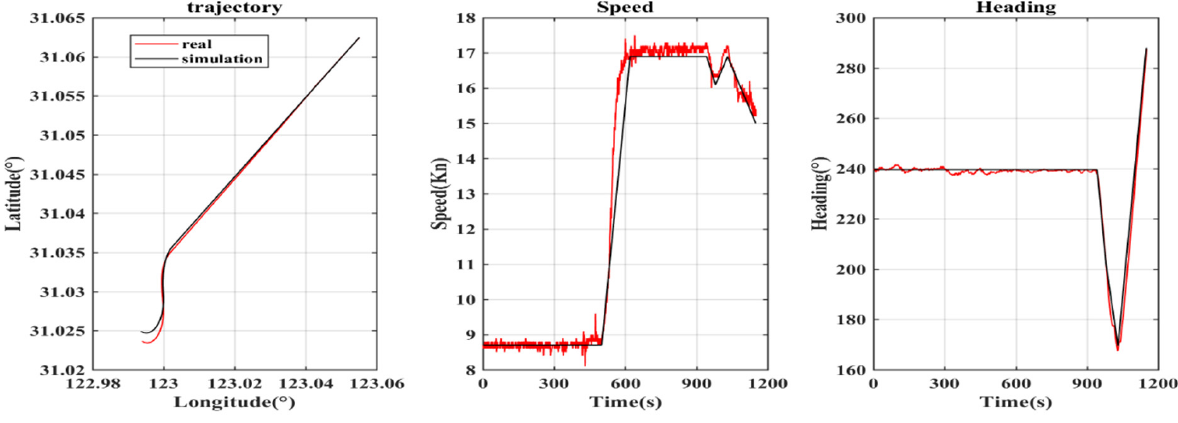
Figure 3. Comparison between measured data and typical trajectory generator.